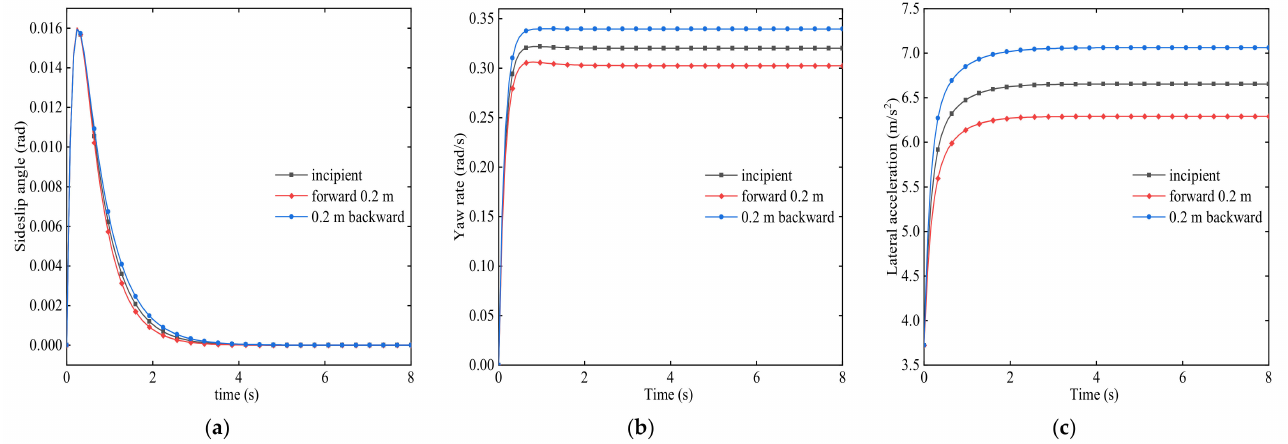
Figure 19. Simulation comparison of centroid change. ( a ) Sideslip angle. ( b ) Yaw rate. ( c ) Lateral